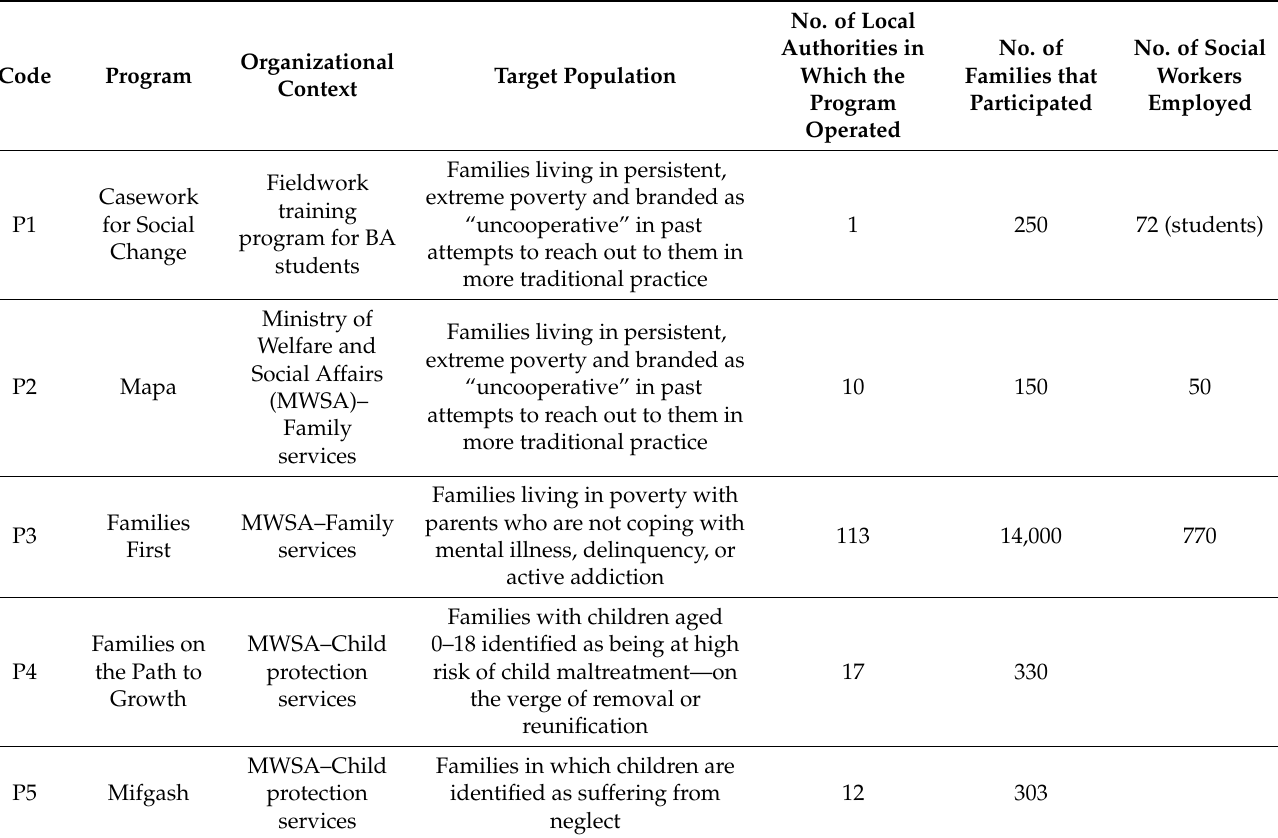
Table 1. Overview of